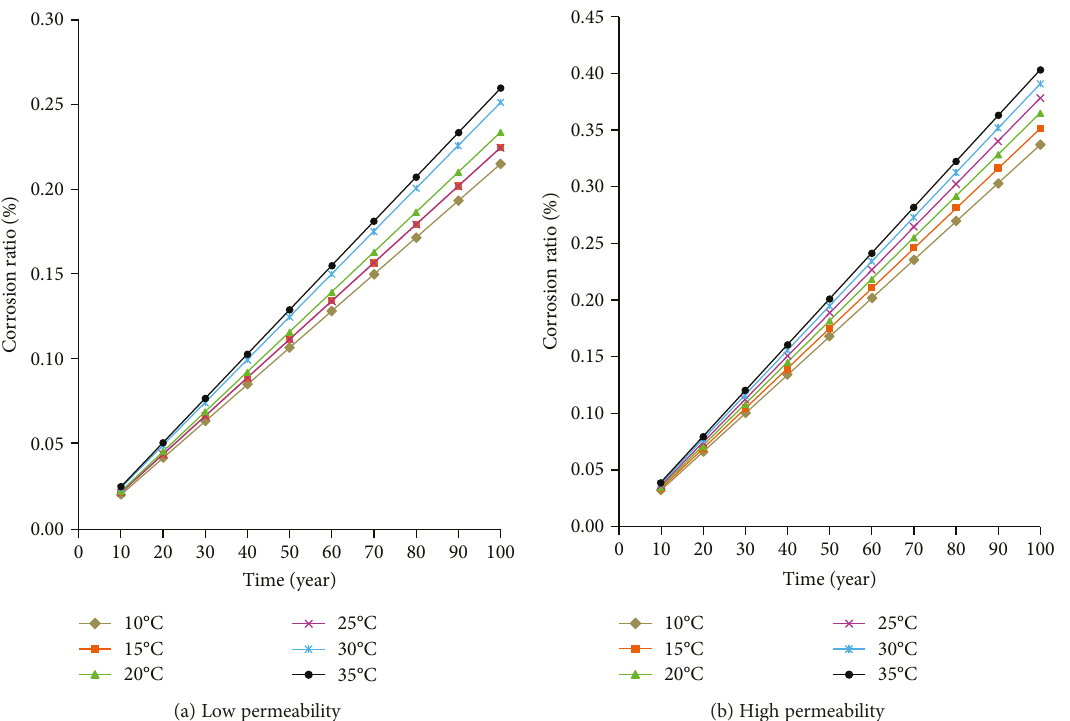
Figure 16: The corrosion ratio of the fi ssure under strong hydrodynamic conditions over time.